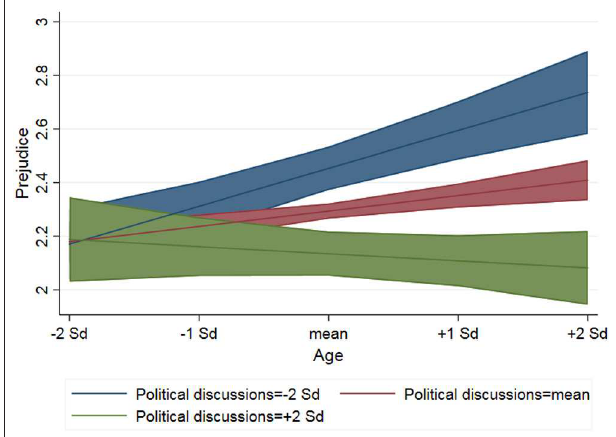
FIGURE 3 | Predicted values from linear mixed repeated measurement model (model 3) with 95% confidence